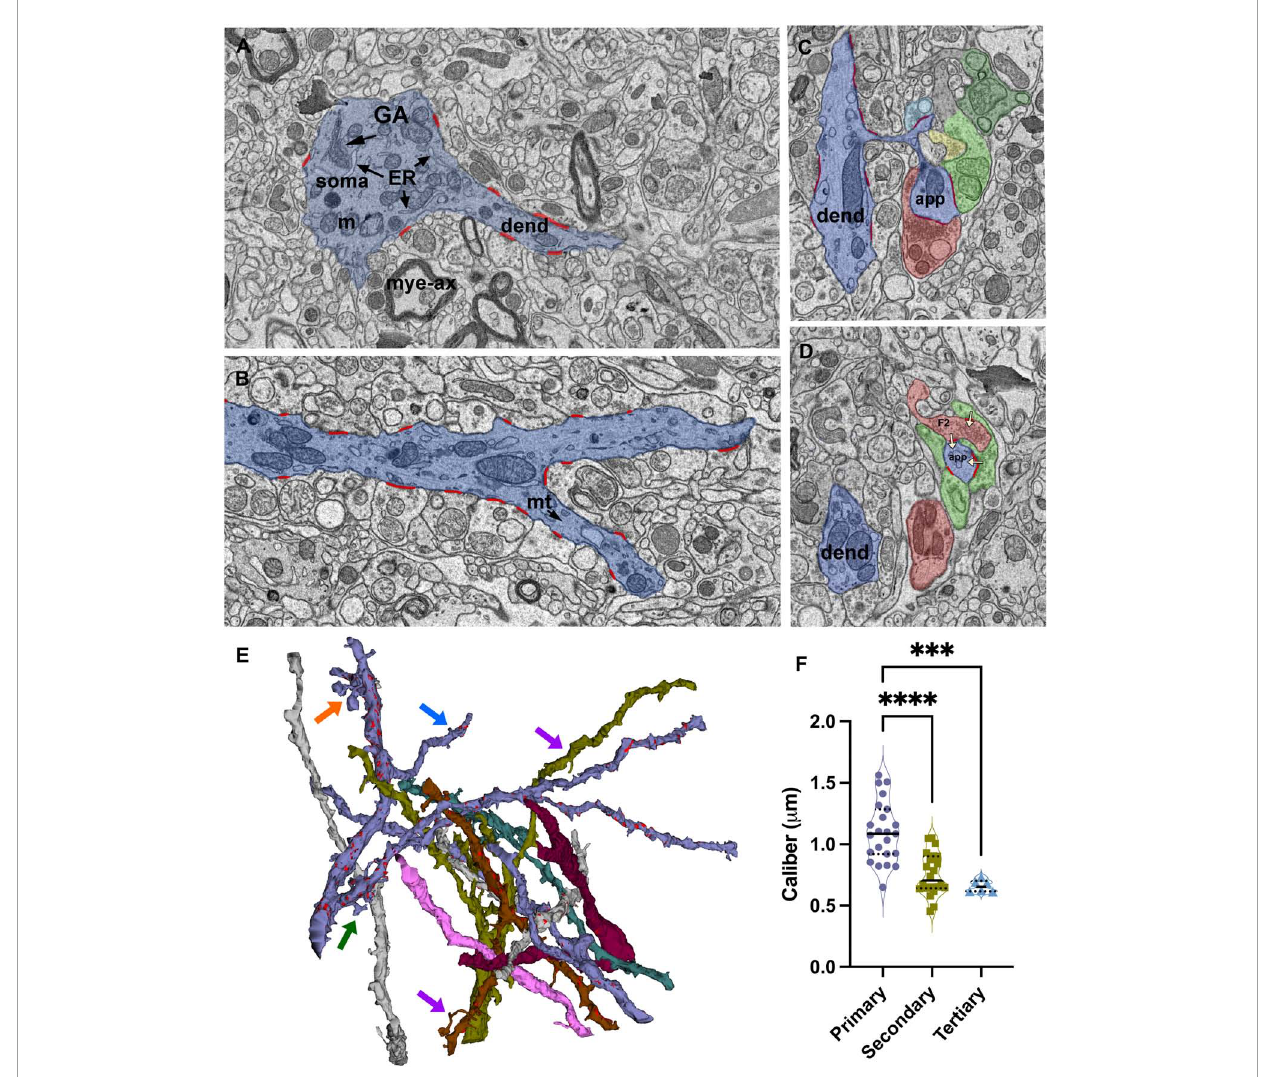
FIGURE2 Identification and reconstruction of primary, secondary, and tertiary dendrite segments of relay cells. (A) The dendrite segments that emerge from profiles containing soma-specific organelles, including Golgi apparatus (GA) and endoplasmic reticulum (ER), are identified as primary segments. Mye-ax: myelinated axon; m: mitochondria; soma: cell body; dend: dendrite. (B) SBEM image of a primary dendrite (blue) splitting into two secondary branches. All synapses (red) formed on the reconstructed dendrite segments are identified and traced. mt: microtubules. (C,D) Cross-sections through a dendritic spine complex or a grape-like appendage (blue), which receives multiple synapses (traced in red; white arrows mark the direction of the synapses) from various input boutons; distinct boutons are pseudocolored following the color-coding scheme of volume sorting. Note that the appendage is engaged in a triad: a presynaptic bouton [F2; (D) ] also receives a synapse from another bouton that contains light mitochondria and synapses on the same appendage. (E) 3D reconstructions of some of the dendrites in the relay dataset. Synapses are marked in red along representative dendrites. Most dendrites give off thin filopodia (e.g., blue arrow) that emerge close to a synapse on the dendrite shaft and protrude into the presynaptic bouton; the synaptic zone often extends along protruding filopodium. Other filopodia emerge from non-synaptic regions, and extend long distances in the extracellular matrix without receiving synapses (e.g., purple arrows). Spines emerge from the dendrite with a thin stalk and form an enlarged head that receives synapses from 2 to 3 different boutons (e.g., green arrow). A grape-like appendage is a spine complex where 2–3 spine heads emerge from the same thin stalk (e.g., orange arrow). Like single spines, grapes also receive multiple distinct synapses and engage in triads. (F) The size distribution of calibers of primary dendrites are significantly larger than both the secondary and tertiary dendrite segments (Kruskal–Wallis, Dunn’s multiple comparisons, ∗∗∗∗ < 0.0001; ∗∗∗ = 0.0004), Tertiary dendrite caliber distribution is statistically indistinguishable from secondary branches ( p = 0.9230). Because the 75th percentile range of calibers in the tertiary branches group overlaps with the 50th percentile of the secondary branches group, no size cutoff can be used to categorize the branches by only a caliber